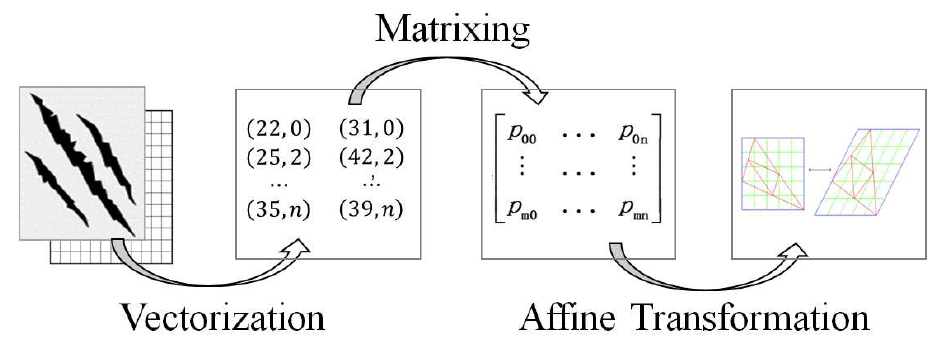
Figure 2. The semantic standardization process.